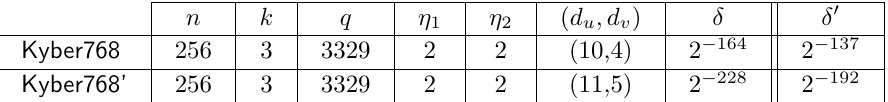
Table 9: Parameter set for Kyber, with the original failure probability δ , and the failure probability δ 0 for ∆ = 0 . 020.